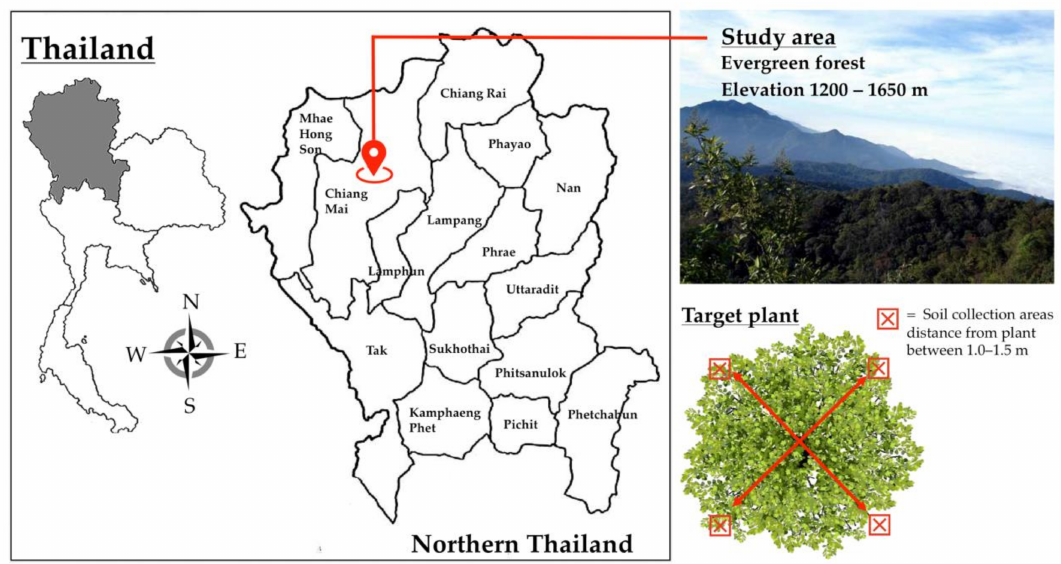
Figure 1. Map showing the study area and position of soil sample collection of each target